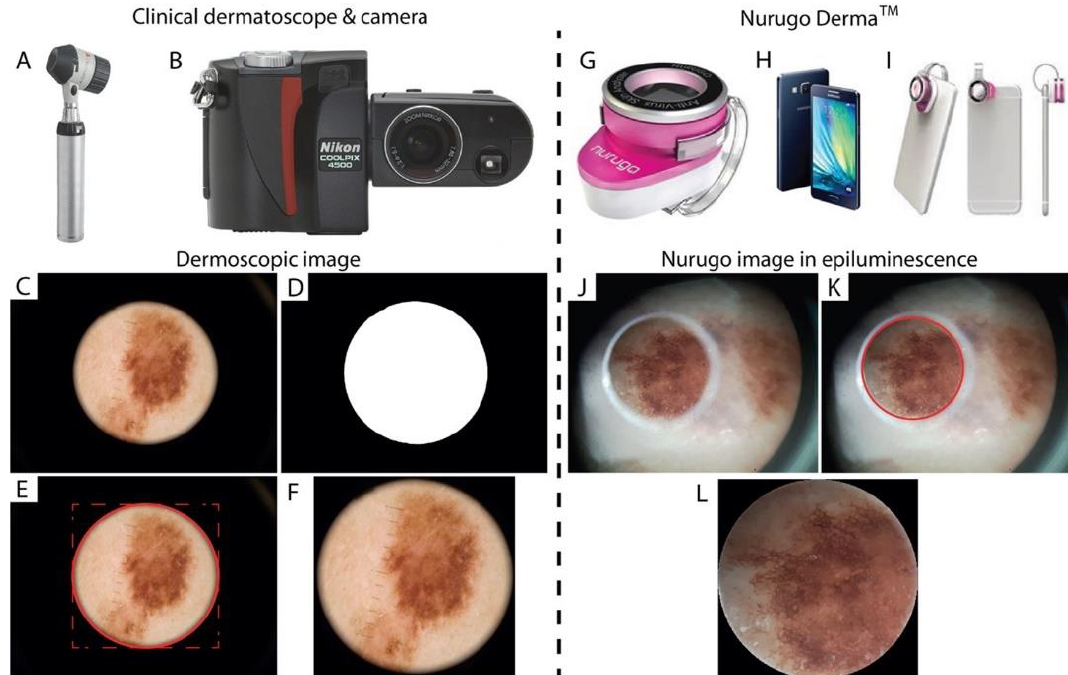
Figure 1. ( Top ) Representation of the portable dermatoscope connected to the camera ( A , B ) and of the Nurugo TM Derma ( G ) connected to the smartphone ( H , I ); ( Bottom ) Examples of images acquired with the different devices and image pre-processing (Dermatoscope from C – F ; Nurugo TM Derma from J – L ).